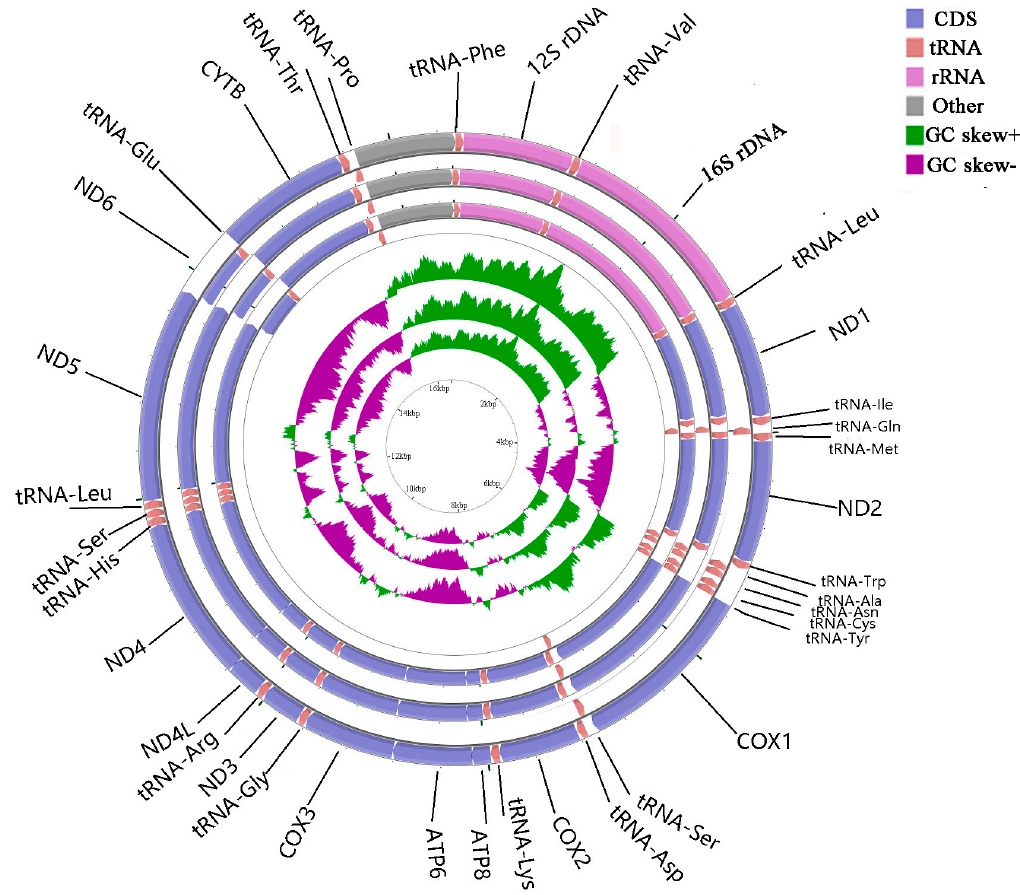
Figure 1 . Gene map of the complete mitogenomes of Alectis indicus , Decapterus tabl, and Alepes djedaba. Note: The larger ring indicates the gene arrangement and distribution; the genes on the outer circle are encoded by the H-strand, and those on the inner circle by the L-strand. The smaller ring indicates the GC content. ND1–6 , NADH dehydrogenase subunits 1–6; COXI–III , cytochrome c oxidase subunits 1–3; ATP6 and ATP8 , ATPase subunits 6 and 8; Cytb , cytochrome b. Table 1. Summary of gene / element features of Alectis indicus, Decapterus tabl , and Alepes djedaba . Gene Element